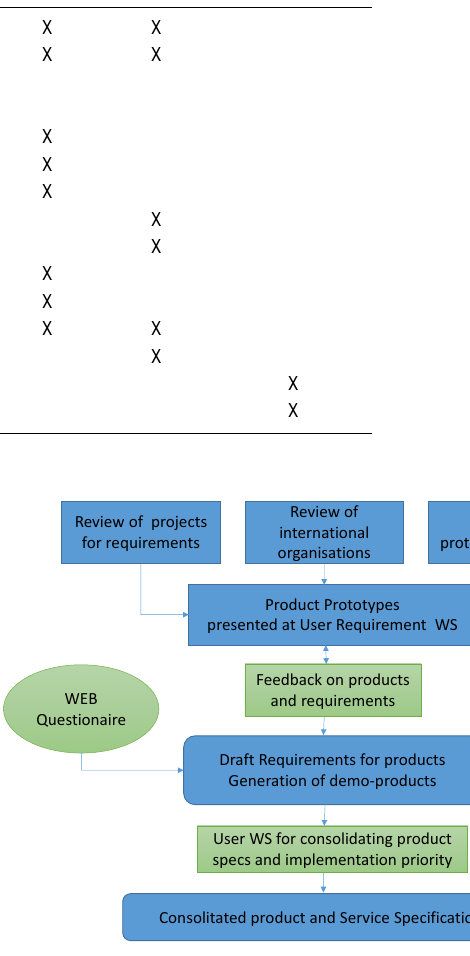
Figure 1. Methods applied to derive user